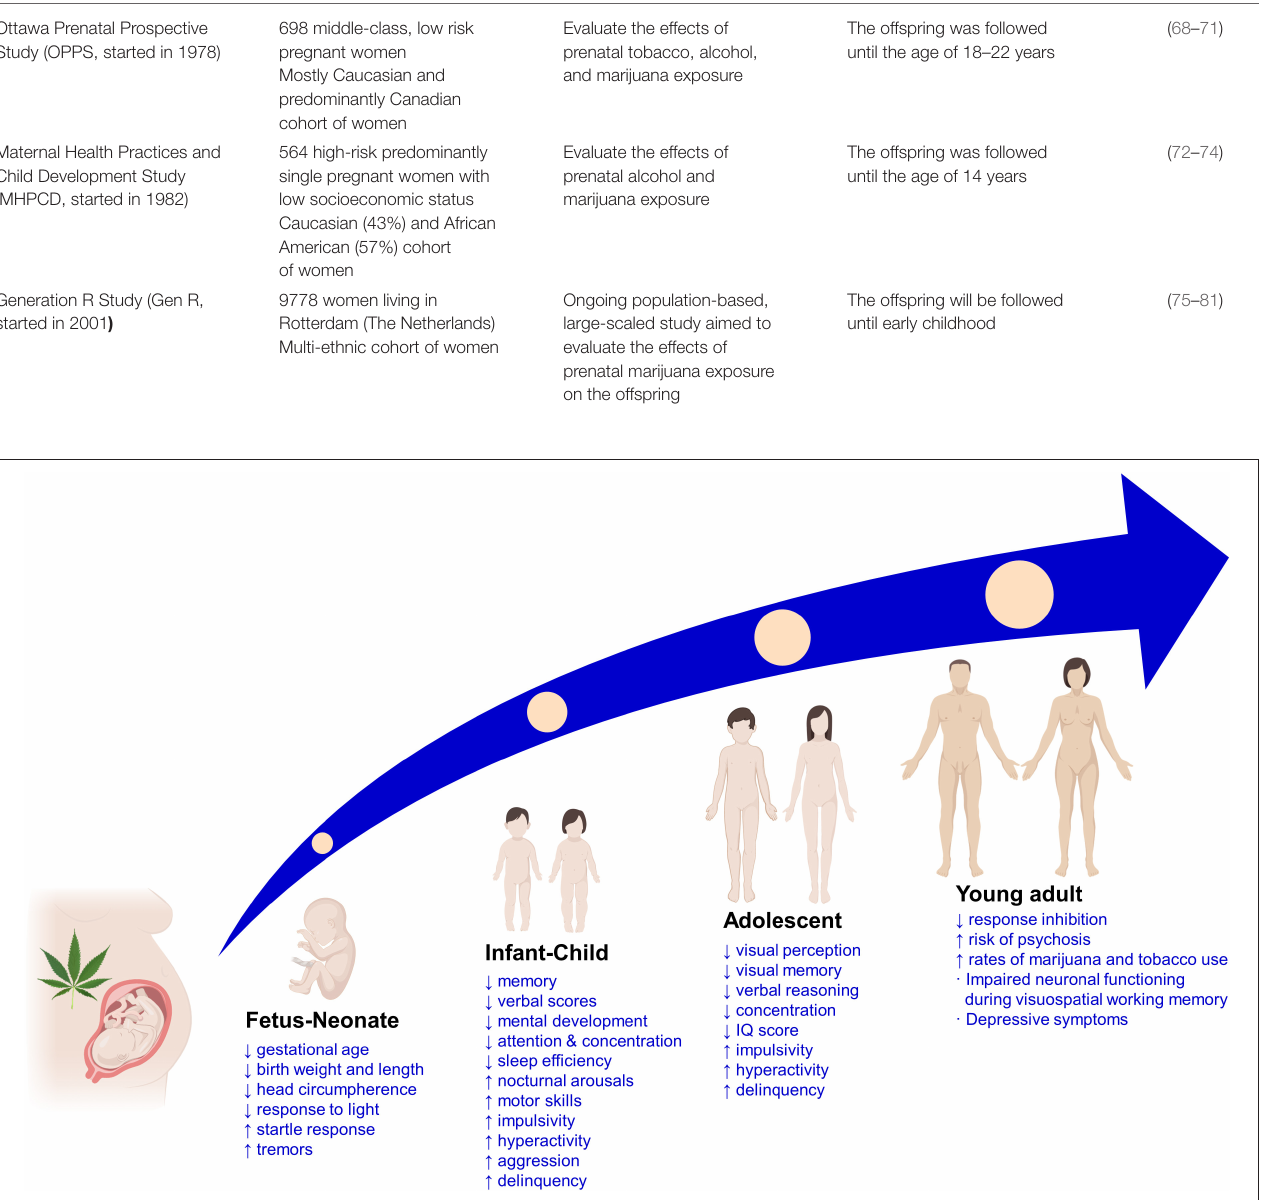
FIGURE 1 | Main clinical findings of the effects of prenatal cannabis exposure on the offspring at different life stages. ↑ , increased; ↓ , decreased; IQ, intelligence